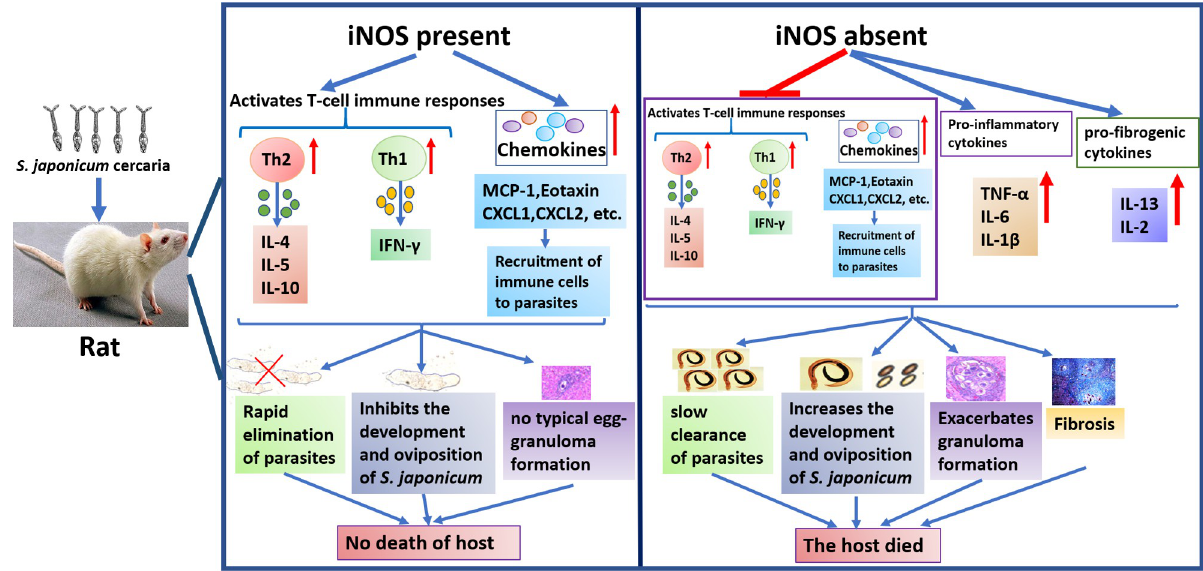
Fig 7. Schematic model for the role of iNOS in maintaining host immune activity against S . japonicum infection in rats. When iNOS is present in rats, T-cell immune responses were rapidly activated upon infection with S . japonicum , with associated consequences: Th2 and Th1 immune cells upregulated, and the secretion of cytokines and chemokines increased. These immune effects mediated by iNOS lead to rapid elimination of schistosome, inhibition of worm development, and no typical egg-granuloma formation in rats. Therefore, schistosomiasis does not cause death in rats. However, T cell responses were impaired in the absence of iNOS in rats, which resulted in delayed clearance of worms, increasing the development and oviposition of schistosomes, a lot of egg-granuloma formation which developed into fibrosis and produced a lot of inflammatory cytokines, eventually leading to the death of the